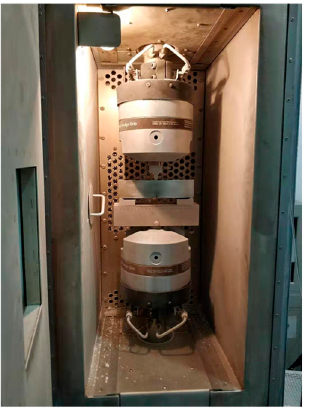
Figure 13. ( a ) The low-temperature three-point bending fatigue experiment. ( b ) The manufactured gap and the major fatigue-crack.